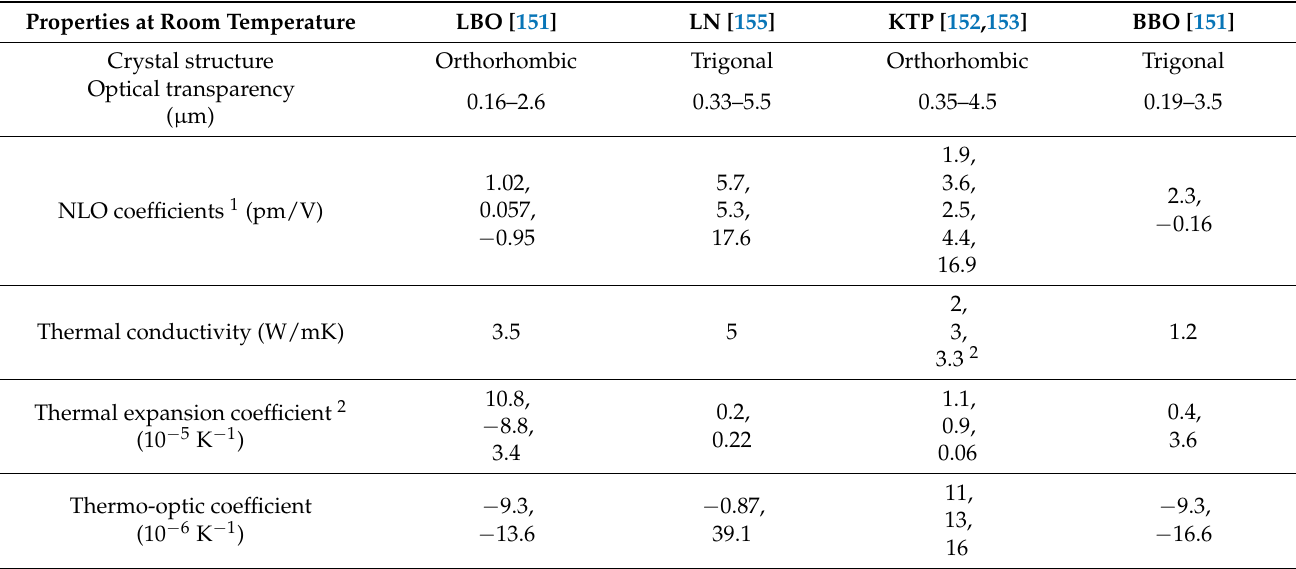
Table 4. Comparison of material properties of OPO